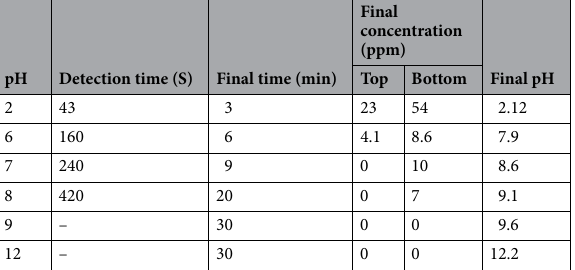
Table 2. Released H 2 S at different pH values in different times at top and bottom of the flask.